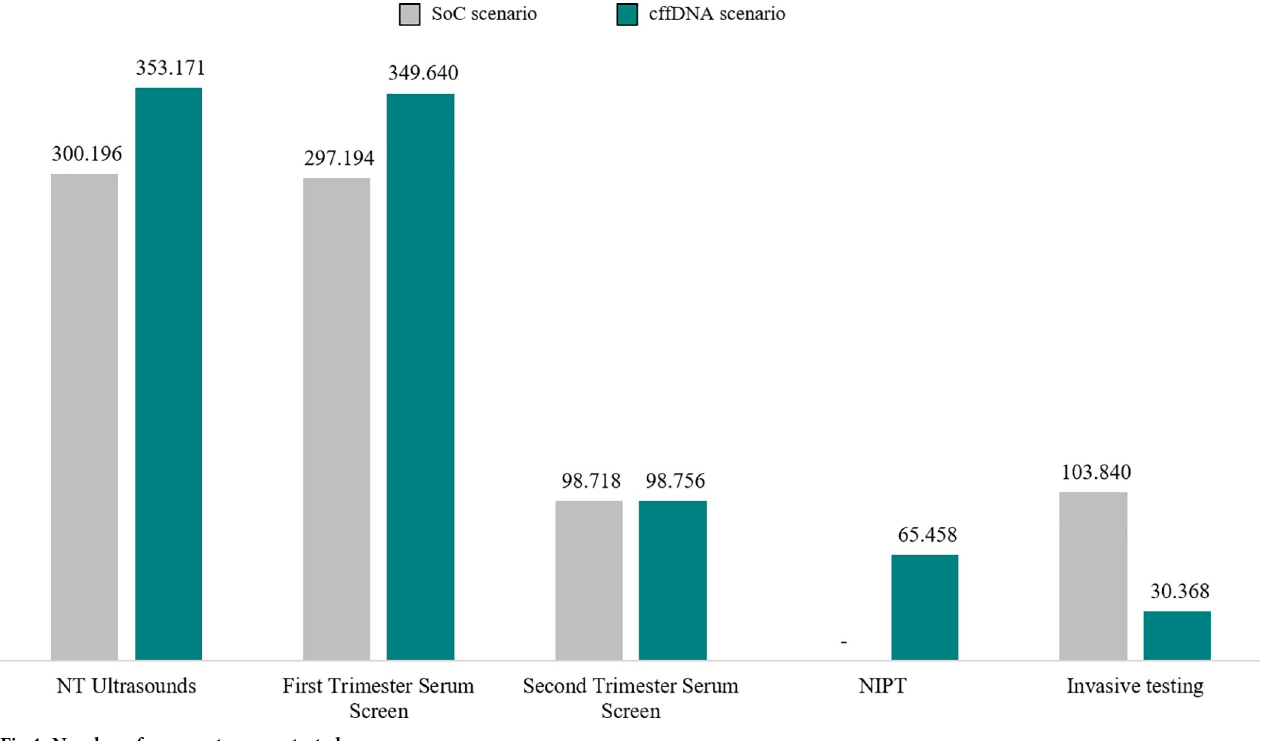
Fig 4. Number of pregnant women